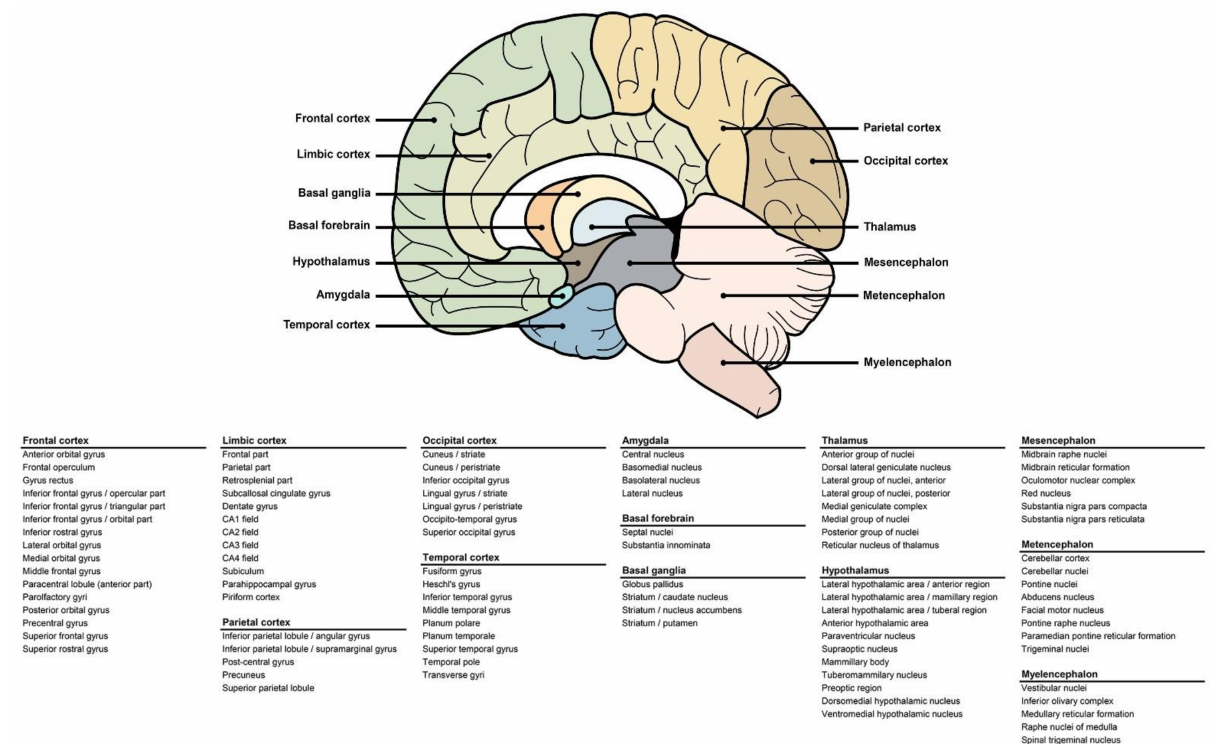
Figure 6. Areas of the human brain included in the study. Visual representation of the human brain with arrows indicating the main areas ( top ). Table detailing the substructures included in each main zone ( bottom